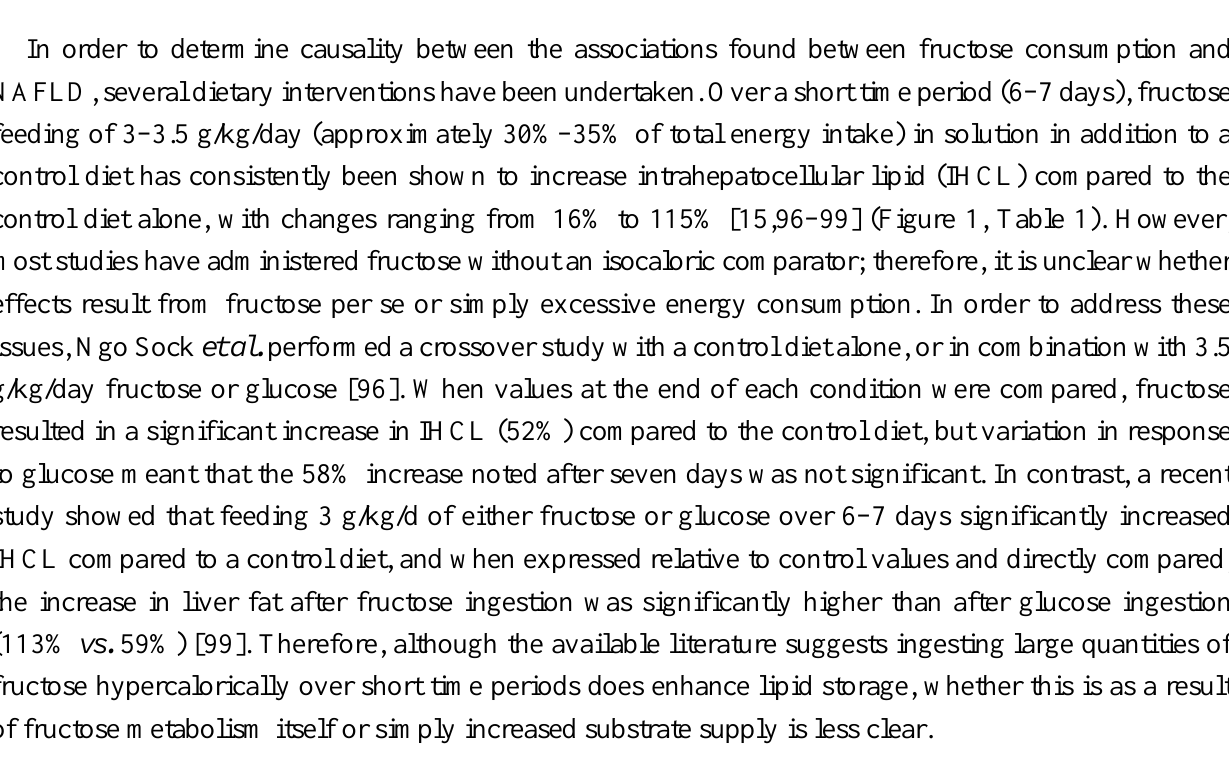
Figure 1. The effect of hypercaloric monosaccharide feeding on IHCL over seven days or less. * Values estimated from figures, T2D; type 2 diabetes, IHCL; intrahepatocellular